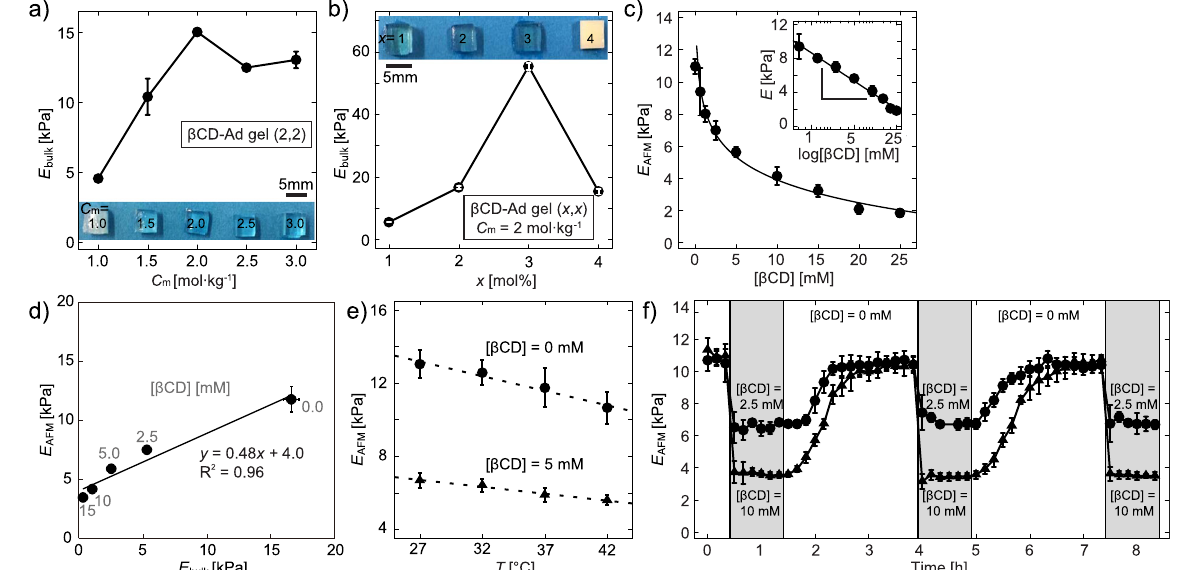
Figure 2. Macroscopic and microscopic gel assessment. ( a ) Young’s modulus E bulk of β CD–Ad gel (2,2) vs. total monomer concentration C m = 1.0, 1.5, 2.0, 2.5, and 3.0 mol kg − 1 , measured by a creep meter. ( b ) E bulk plotted as a function of the mol% content of β CD–AAm and Ad–AAm monomers in the monomer solution ( x ), while keeping C m = 2.0 mol·kg − 1 constant. ( c ) E AFM of β CD–Ad gel (2, 2) vs. β CD concentration, measured at RT. The change in elasticity shows a clear dependence on β CD concentration; β Δ ∝ E CD log[ ] . ( d ) Correlation AFM between E bulk measured by a creep meter and E AFM measured by AFM indentation. β CD–Ad gel (2,2) with C m = 2.0 mol kg − 1 was immersed into RPMI 1640 medium containing 0, 2.5, 5.0, 10, and 15 mM of β CD. ( e ) Temperature dependence of E AFM in the presence and absence of 5 mM β CD. ( f ) In situ modulation of E AFM at T = 37 °C. Reversible switching of the substrate elasticity was confirmed by alternatively changing β CD concentration in the solution between 0 and 2.5 mM ( ● ) as well as 0 and 10 mM ( ▲ ).